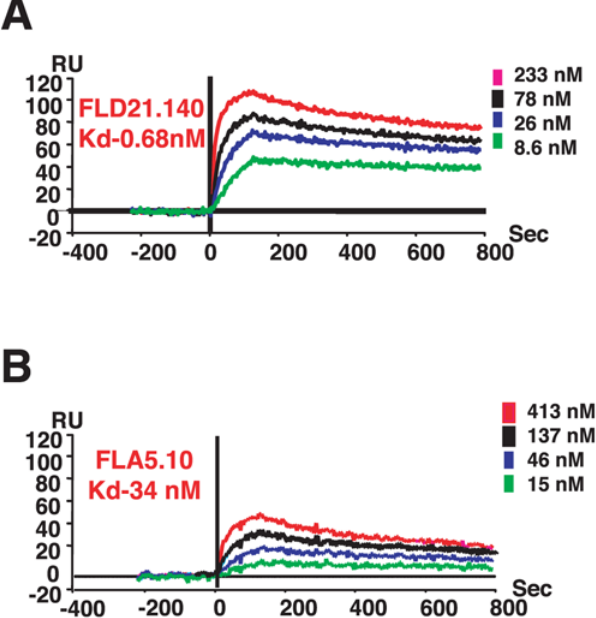
Figure 2. Steady-state binding equilibrium analysis of human MAbs to purified bacterially expressed H5 HA[(-10-223)] fragment. Various concentrations of MAbs FLD21.140 (A) and FLA5.10 (B) were injected simultaneously onto recombinant HA [(-10)- 223] (identified in Figure 1B) peptide, immobilized on a sensor chip through the free amine group, and onto a blank flow cell, free of peptide. Binding was recorded using ProteOn system surface plasmon resonance biosensor instrument (BioRad Labs). As a control, anti-CCR5 MAb 2D7) was injected at the same concentrations on HA [(-10)-223] coupled chip. RU, resonance